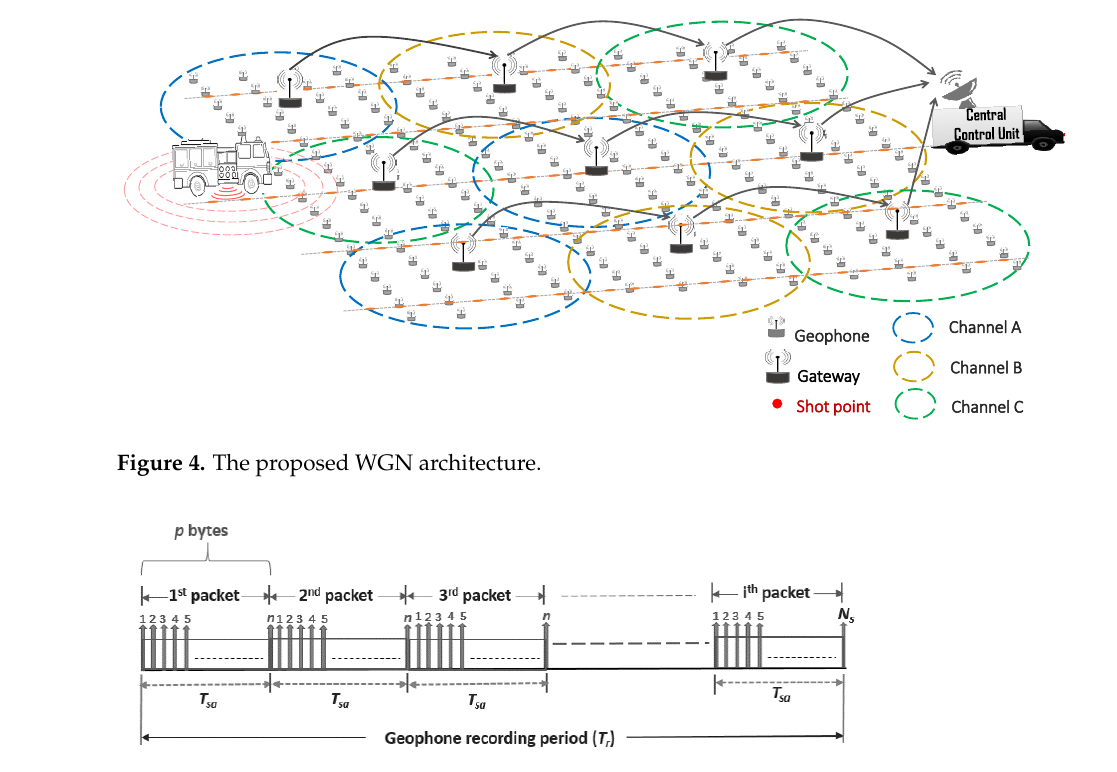
Figure 5. Geophone recording period acquisition data traffic